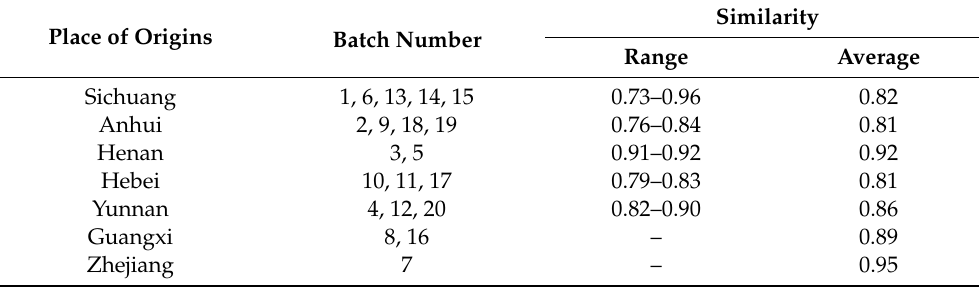
Table 7. Similarity of Psoralea corylifolia L. collected from di ff erent